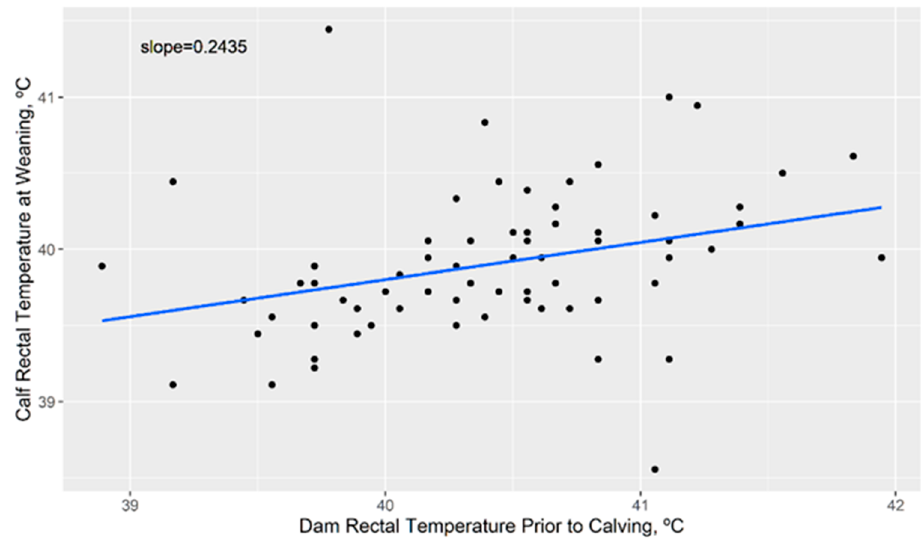
Figure 7. Calf rectal temperature at weaning is significantly associated ( p < 0.05) with dam rectal temperature prior to calving, regardless of novel or toxic fescue exposure. Cow rectal temperatures were taken 1–2 months prior to calving. These data may indicate the genetic or epigenetic tuning of calf temperature in response to heat stress in utero.